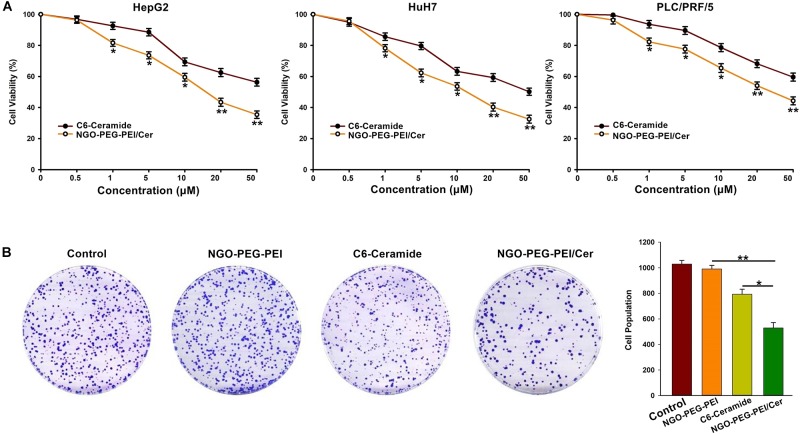
In vitro anti-tumor activity of NGO-PEG-PEI/Cer. (A) Cells were seeded in 96-well plates and infected with NGO-PEG-PEI/CER or C6-ceramide at a series of concentrations. Cell viability was determined by MTT cell proliferation assays at 48 h post-infection. The results were presented as mean ± SD of three separate experiments. (B) Clonogenic formation of HepG2 cells treated by NGO-PEG-PEI/Cer. ∗P < 0.05, ∗∗P < 0.01.